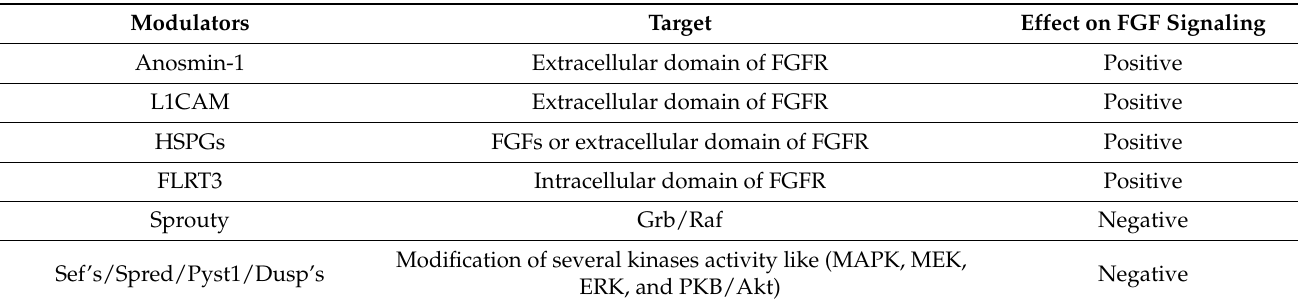
Table 2. Prominent protein modulators of FGF signaling with context and species dependent effects.